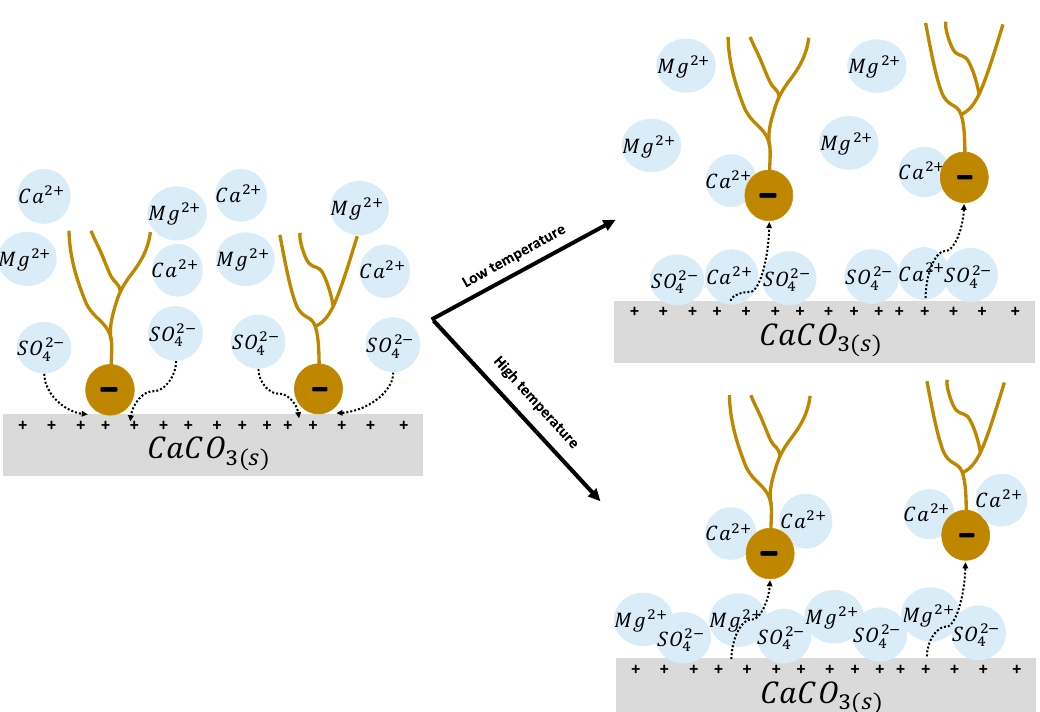
Figure 13. An illustration of the proposed mechanism of wettability alteration by “MIE” in carbonate reservoirs showing the polar oil component displacement from the carbonate rock surface through PDIs competition. Original state ( left ), Low temperature state ( right upper ) and High temperature state above 100 °C ( left lower ) (adapted from Zhang et al. [59]).